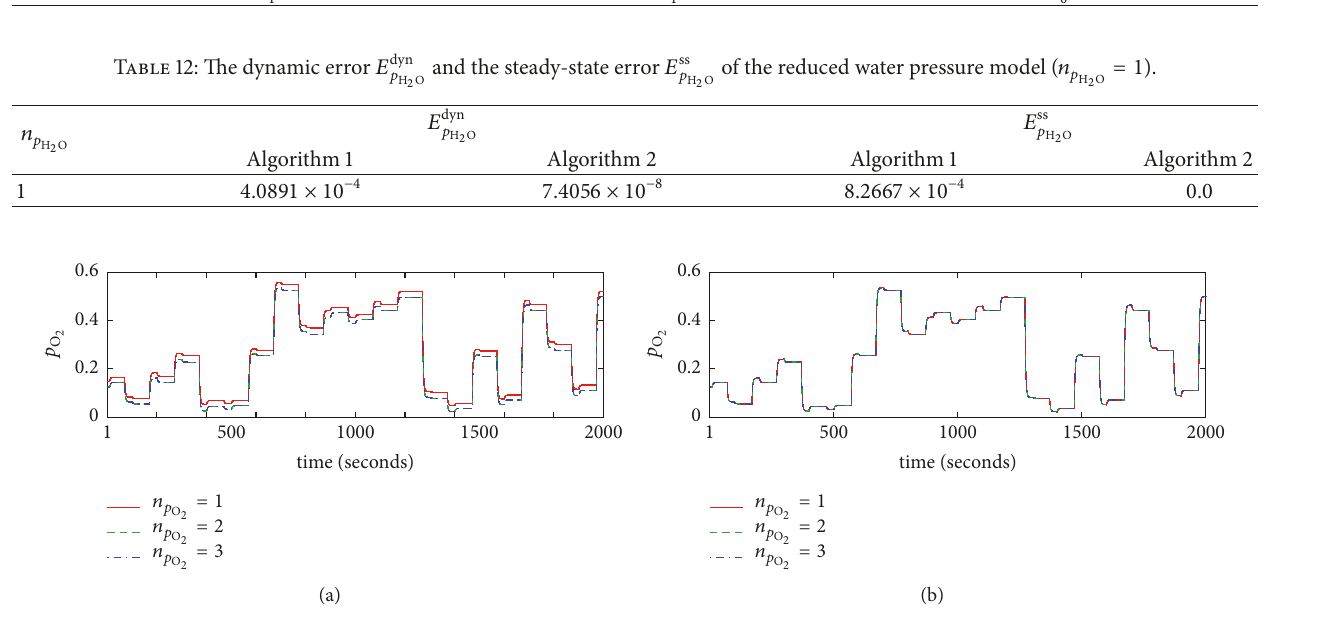
Figure7:Theoxygenpressuretrajectoriescalculatedbyreducedorder( 𝑛 𝑝 1 (a) and algorithm 2